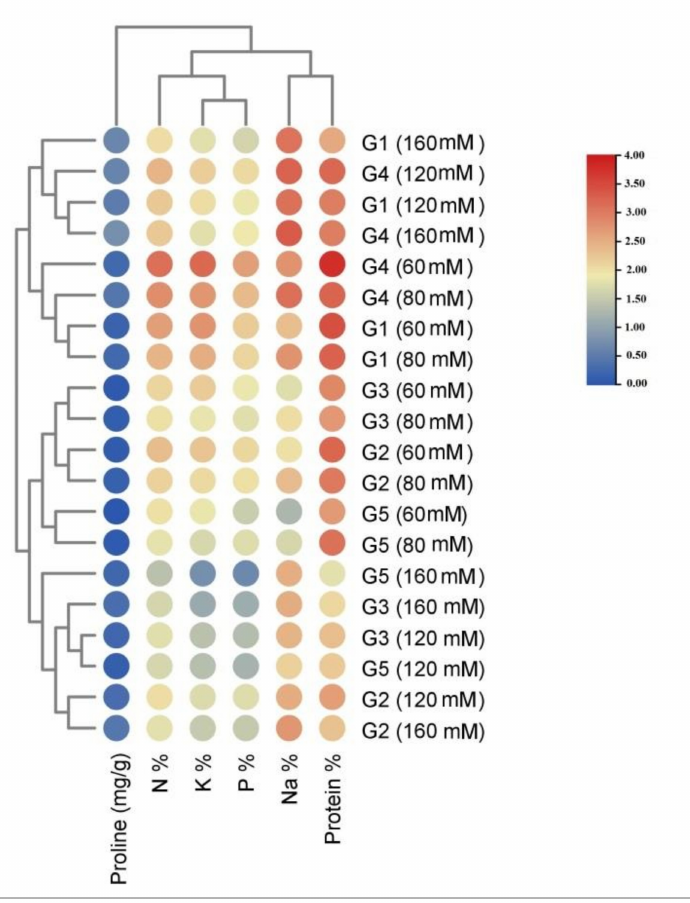
Figure 7. Heat map based on elements and phytochemical compounds of quinoa genotypes treated with different concentrations of NaCl; G1: M-28; G2: Q-37; G3: S-10; G4: Regeolone-3; G5: Line